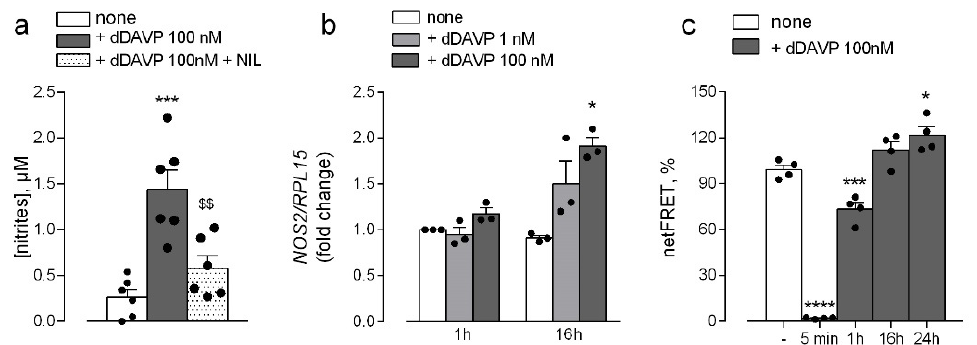
Figure 5. Effects of desmopressin on the expression and activity of inducible nitric oxide synthases in microvascular endothelial cells. HLMVEC were maintained in the presence of the indicated concentrations of dDAVP. ( a ) The production of NO was assessed through the quantitation of nitrites in the incubation medium upon treatment for 48 h in the presence of iNOS inhibitor N 6 -(1-iminoethyl)-L-lysine (NIL; 100 µ M). Data are means ± SEM of six independent determinations. ( b ) The expression of NOS2 was measured after 1 and 16 h with RT-qPCR and normalized for that of the housekeeping gene RPL15. Data are means ± SEM of three experiments, each performed in duplicate. ( c ) After the treatment, cells were transiently transfected with the EPAC-based FRET sensor target to cytosol (H96) or specifically to mitochondria (4mtH30) and the FRET analysis was performed as described (see Methods). Bars represent the mean ± SEM of four independent experiments. * p < 0.01, *** p < 0.001, **** p < 0.0001 vs. none, $$ p < 0.01 vs. dDAVP with a two tailed Student’s t-test for unpaired data.